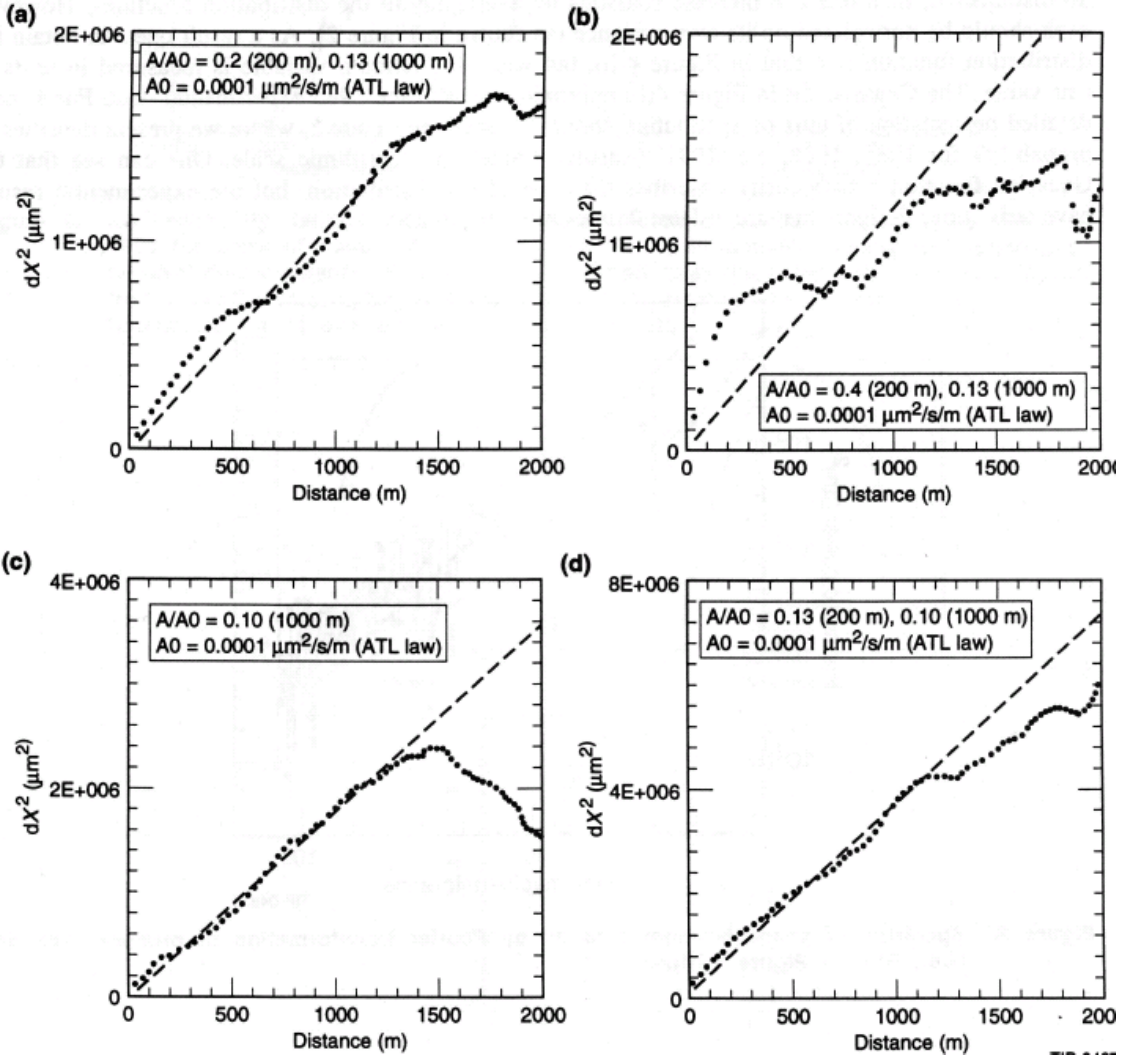
FIG. 16. The variance of the relative vertical displacement of the SPS magnets after various time intervals vs distance between the points of the position survey L : (a) three years (1985–1988), (b) three years (1988–1991), (c) six years (1985–1991), (d) 12 years (1976–1988) (from Ref.